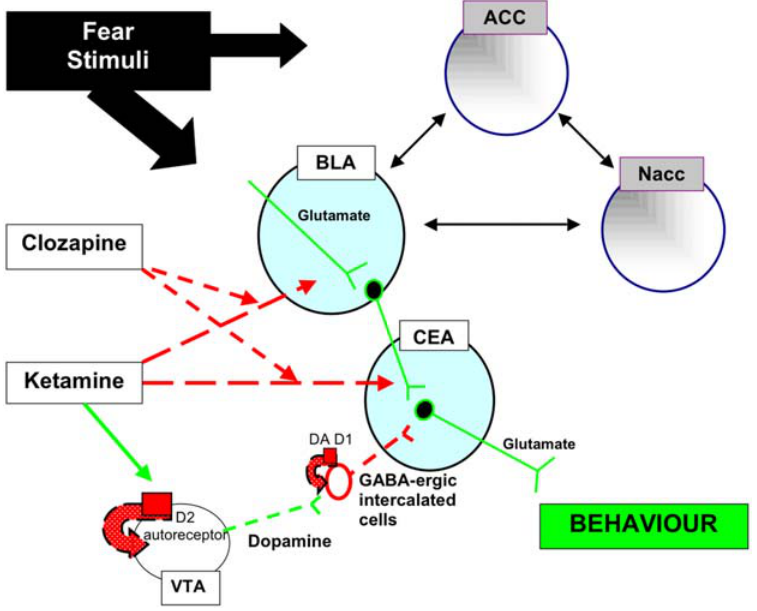
Figure 7. Conceptual model. A schematic drawing of our conceptual model depicting interactions between dopamine and glutamate in the amygdala nuclei. The interactions between other brain areas studied and the amygdala conceptual model are also indicated. Dashed lines symbolize inhibition, while solid lines represent stimulation. Lines between brain areas represent functional connectivity between the regions. Fear stimuli are processed first by the basolateral amygdala (BLA), activating the glutamate system in this area, but do not affect dopamine levels in either the BLA or central amygdala (CEA). Output signals inducing freezing behavior from the CEA are therefore strong via the glutamate pathway. Ketamine decreases glutamate-related fear processing in the BLA and CEA and simultaneously elevates dopamine content (storage) in the CEA, by blocking dopamine release via the dopamine D 2 autoreceptor located on the cell body (possibly the VTA). The decreased dopamine release (together with the block of glutamate transmission from the BLA to the CEA) blocks the fear-related outputs by means of increased GABA inhibition via intercalated cells projecting onto the CEA. The net effect is weak output signals from the CEA and diminished freezing behavior. Clozapine, while blocking the effects of ketamine on glutamate-related processing in the BLA and CEA, does nothing to prevent changes in dopamine levels. GABA-ergic intercalated cells therefore continue to inhibit CEA and/or BLA and normal fear-conditioned behavior cannot be retained. Can chronic clozapine treatment renormalize dopamine levels and lead to long-term remediation of negative symptoms in the animal model? ACC, anterior cingulate; DA, dopamine; LC, locus coeruleus; Nacc, nucleus accumbens; PVN, paraventricular nucleus; VTA, ventral tegmental area